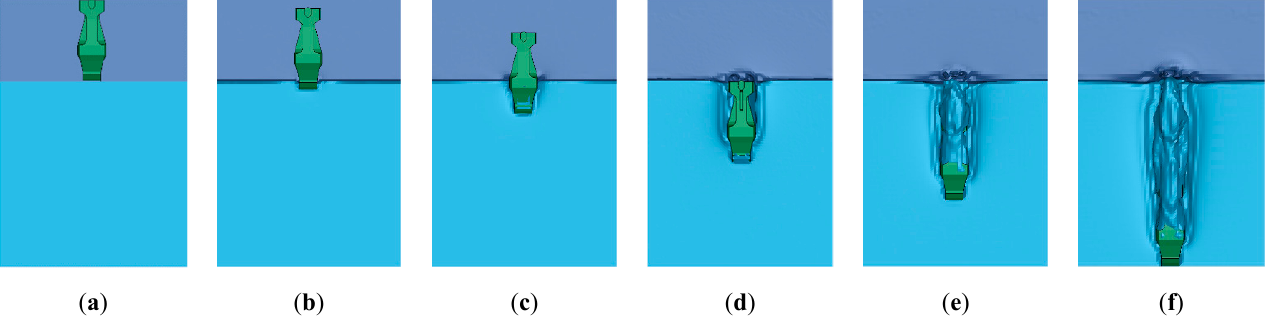
Figure 13. Underwater movement of the crusher (B-2): ( a ) 0.000 s; ( b ) 0.100 s; ( c ) 0.200 s; ( d ) 0.325 s; ( e ) 0.400 s; ( f ) 0.520 s.